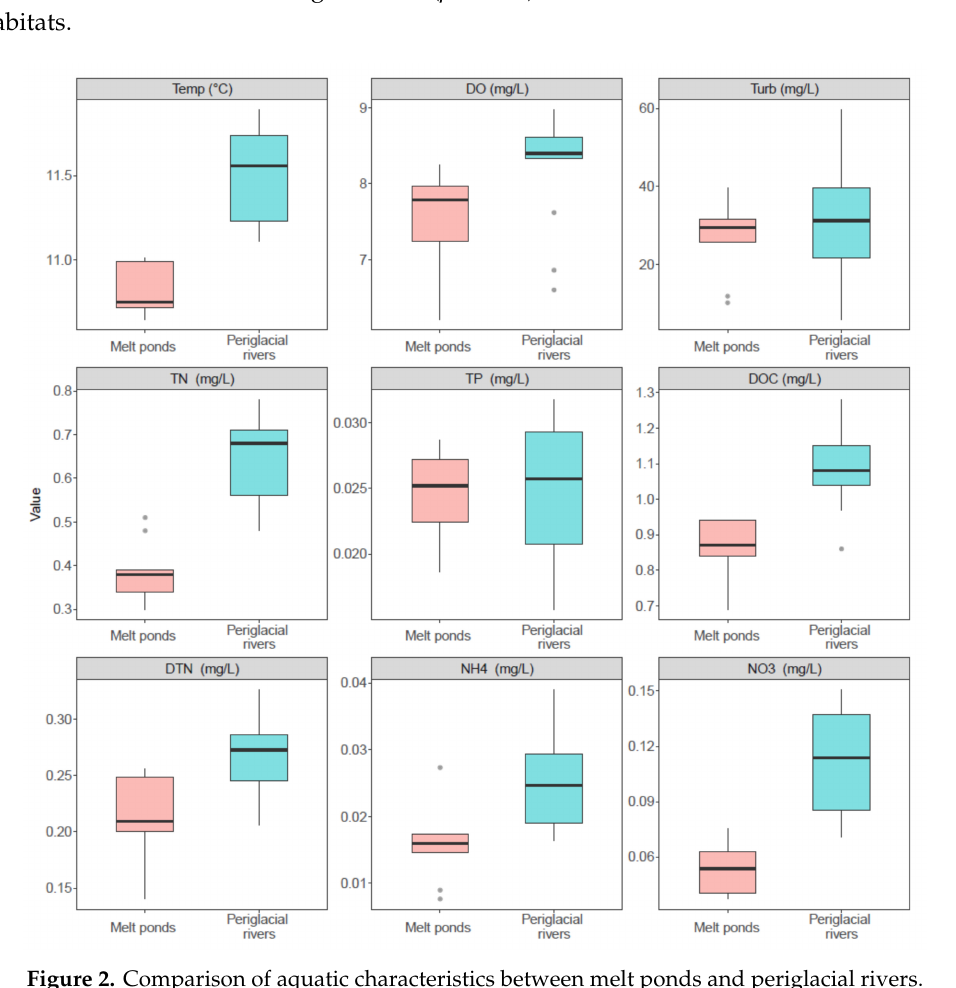
Figure 2. Comparison of aquatic characteristics between melt ponds and periglacial